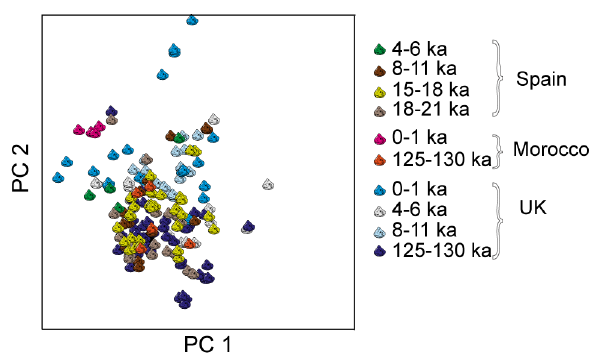
Figure 2. PCA scores plot for Patella . Scores plot for the first two principal components obtained from data for shells of the Patella genus. The plot shows no consistent pattern with either age or country of origin. Age bins are given in thousand years.